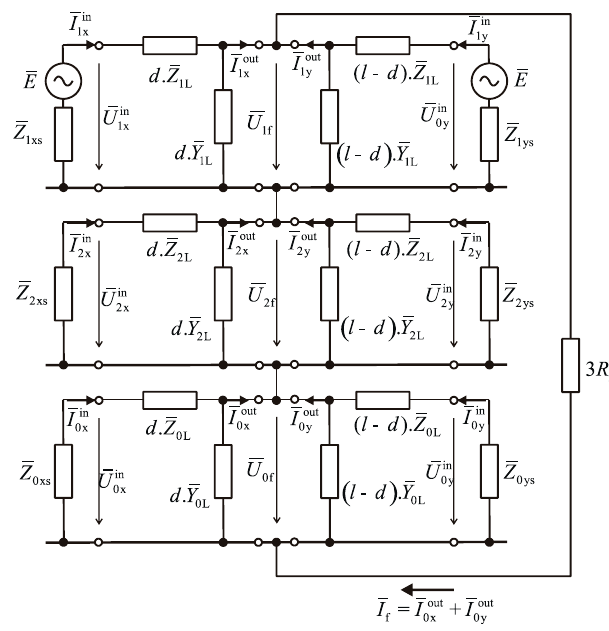
. Figure 3. A zero-sequence component equivalent circuit for parallel-operated transmission lines. 2.2. Two-Terminal Algorithm